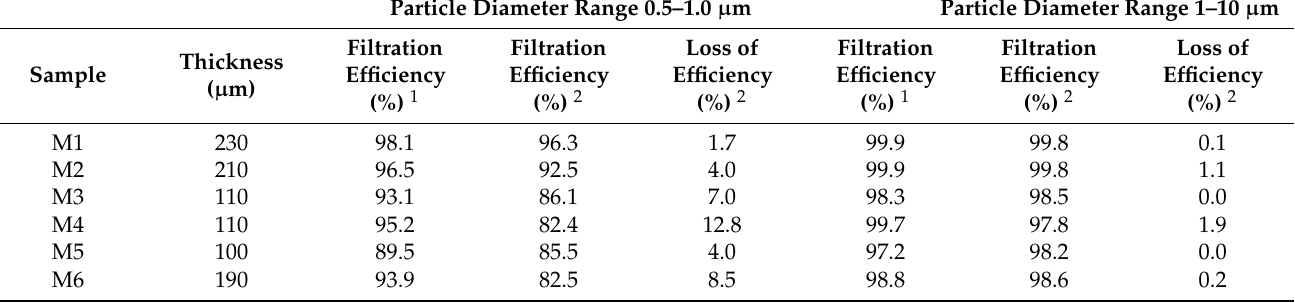
Table 3. Loss of filtering efficiency after 4 months of samples stored at room temperature (0.5–1.0 µ m and 1.0–0.0 µ